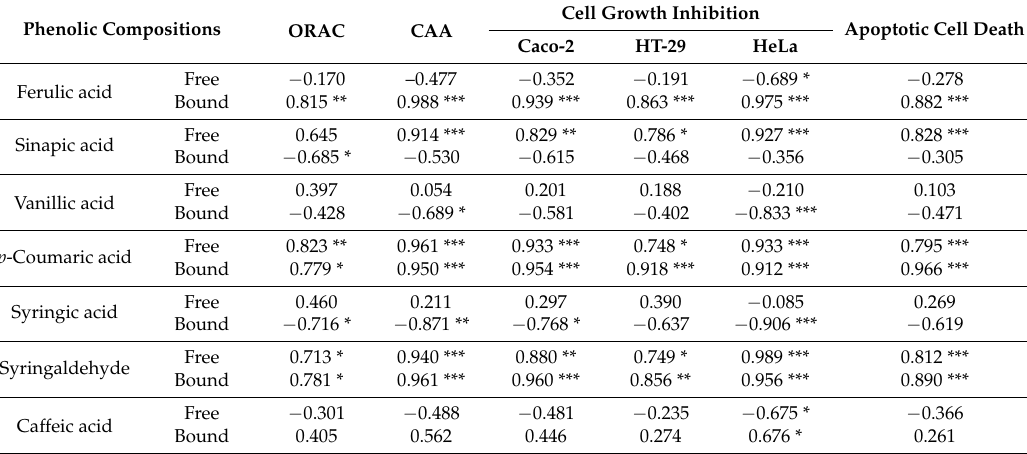
Table 4. Correlation coefficient (r) between phenolic compositions of mature, immature, and steamed immature wheat bran and antioxidant capacity or cellular antioxidant activity or cell growth inhibition or apoptotic cell